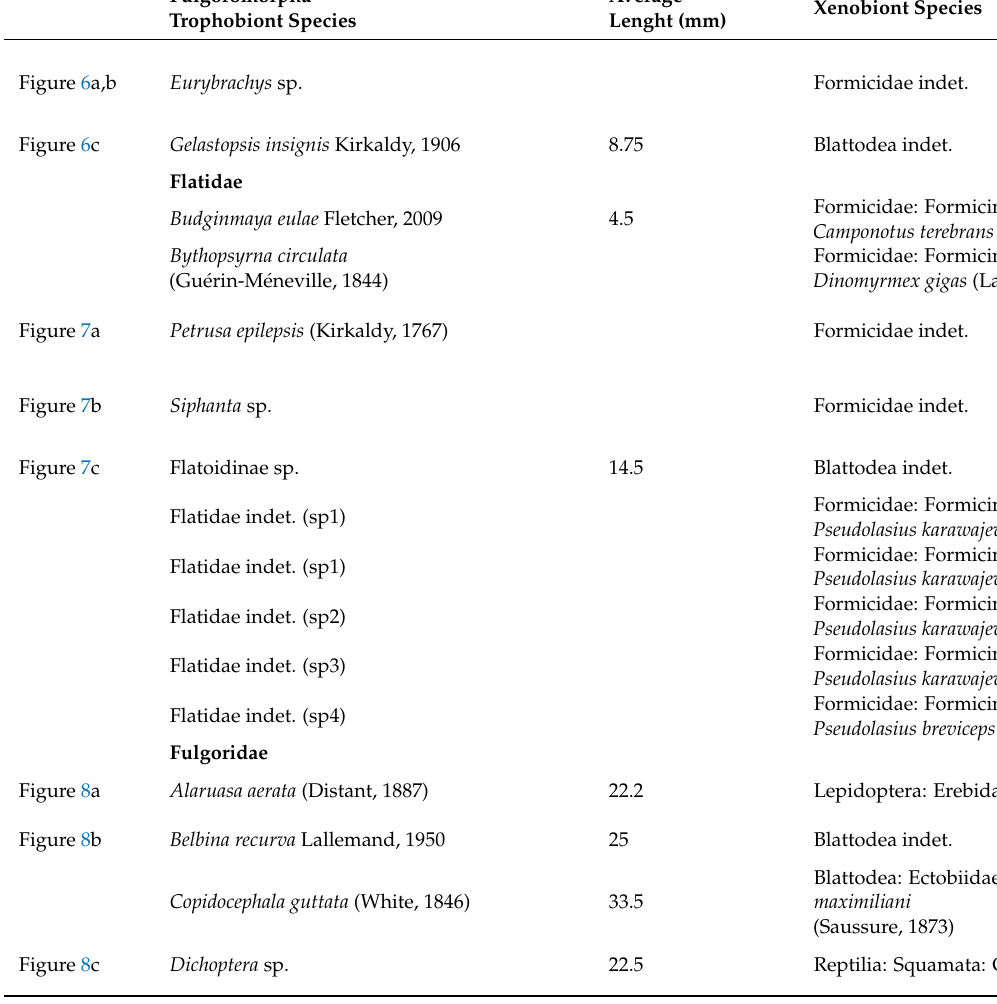
Eurybrachys sp. Gelastopsis insignis Kirkaldy,